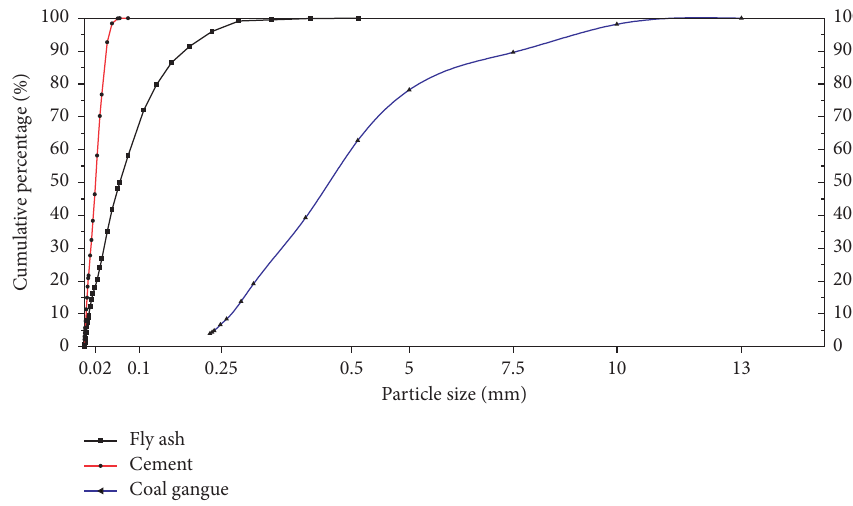
Figure 1: Distribution of material particles’ size. Table 1: Chemical composition of materials. Chemical component Cement Fly ash Coal gangue